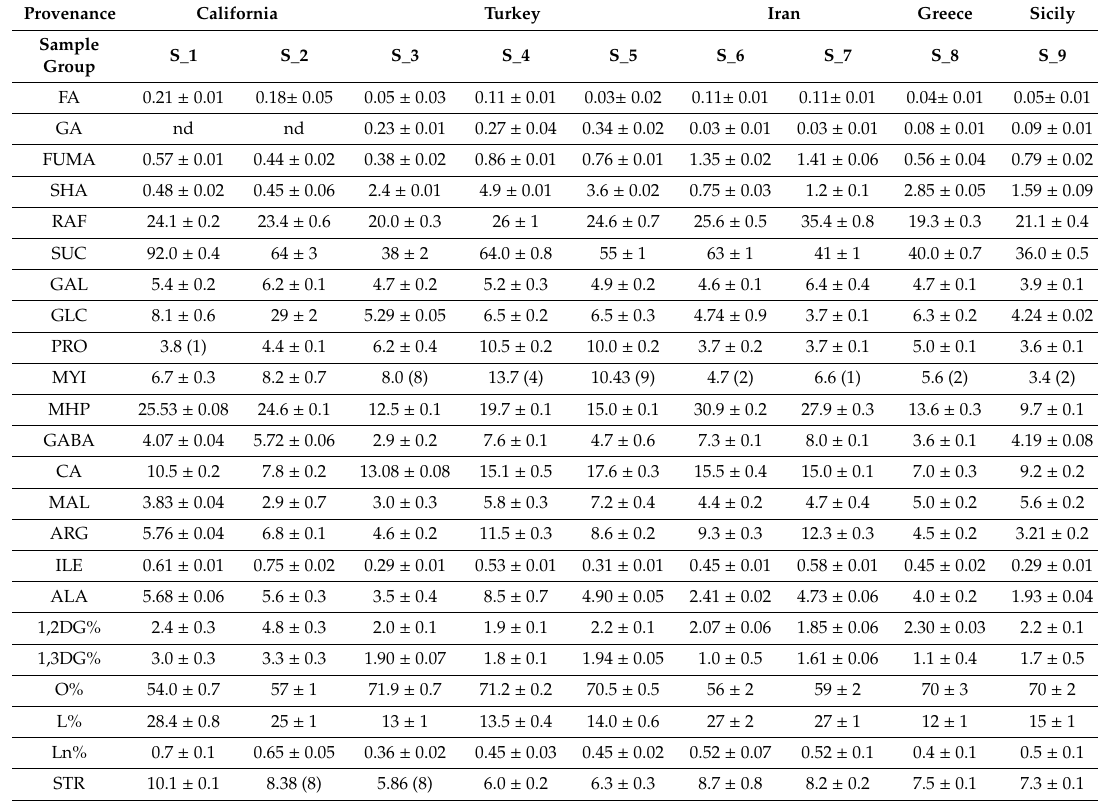
Table 2. Average quantification of metabolites whose code is explained in Table 1. The nine sample types with the inter-variability are reported. Extended quantification for each sample is reported in Table